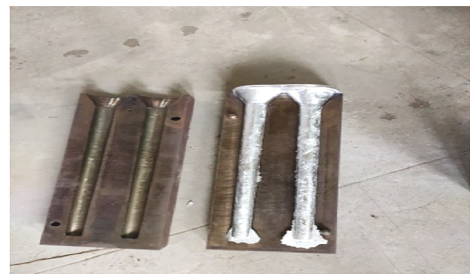
Figure 7: Die used in casting